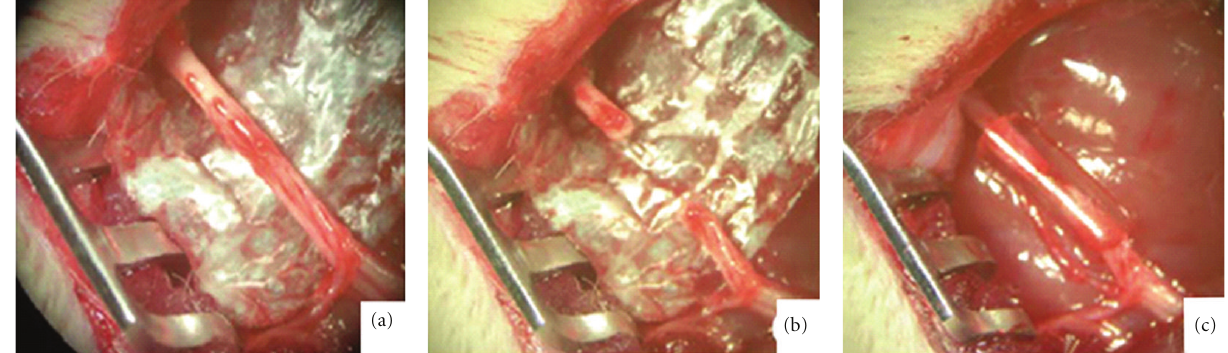
Figure 12: Normal intact right sciatic nerve was cut in the middle (a), removing 4-5mm nervous tissue. AGMA1 hydrogel tube has been used to regenerate the gap (c) [64].